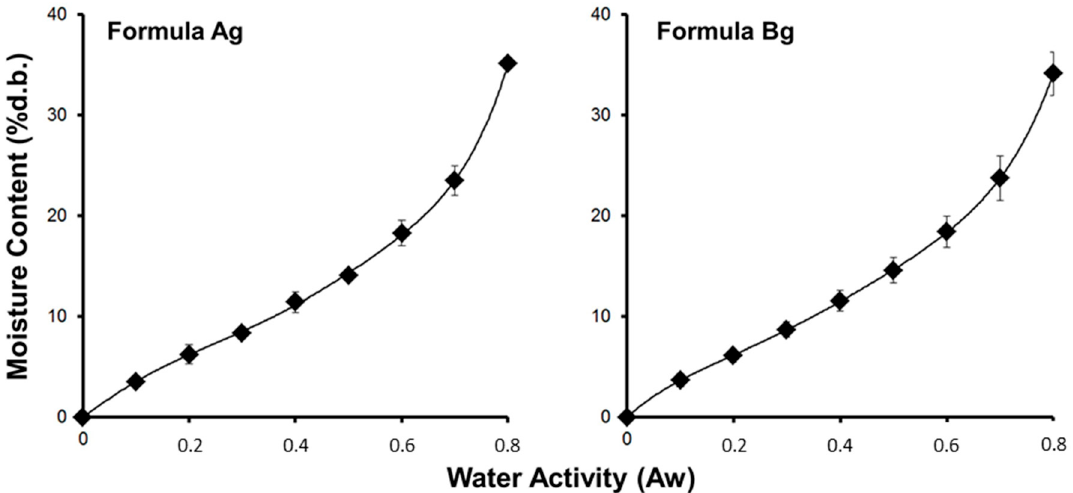
Figure 5. Sorption isotherms of scaffolds.